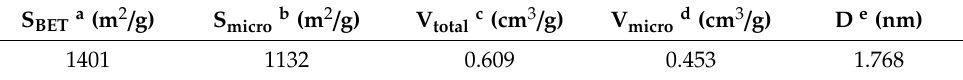
Table 1. Textural properties of the carbon materials.